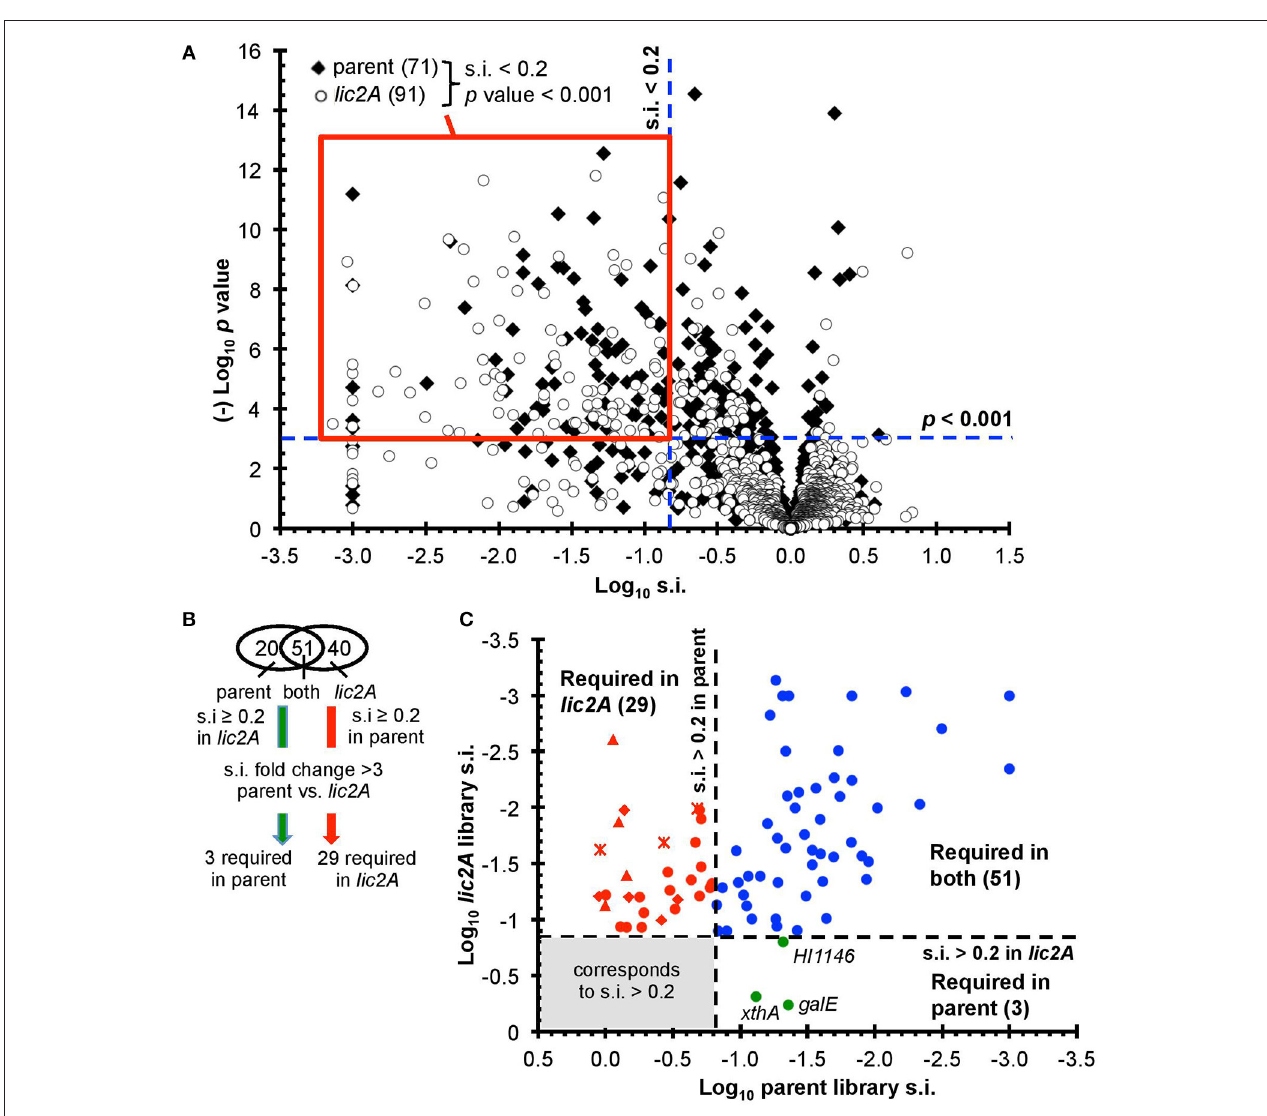
FIGURE 2 | Genome-wide genetic interaction screen via HITS evaluating fitness of H. influenzae mutants in a lic2A deletion background in a mouse lung model. (A) Mutant fitness (survival index, s.i.) of candidate virulence genes in parent and lic2A deletion with no observed effects on fitness in vitro was plotted against significance ( p -value). Red box demarcates the genes of interest meeting the requirements for further analysis (s.i. < 0.2, p -value < 0.001). (B) Venn diagram displaying these genes of interest sorted into categories. Further criteria were imposed to identify candidate genes required for infection in parent, lic2A only or in both. (C) Fitness of the transposon mutants attenuated in the parent or lic2A or in both was plotted against each other, highlighting their differential s.i. phenotypes. The 3 genes required for parent alone (green) or 29 in lic2A alone (red) are displayed ( lsg , crosses; lic1 , triangles; yrb , diamonds) ( Table 2 ). The 51 genes required in both (blue) in vivo conditions are listed in Table S4